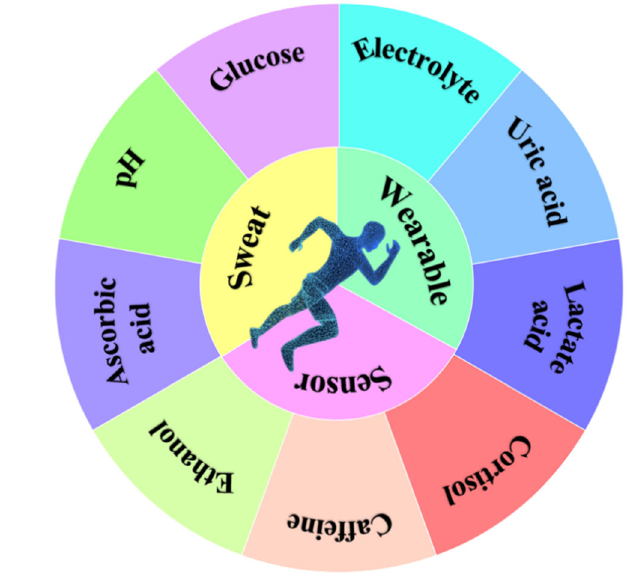
Figure 1. A diagram of the different common components in sweat .